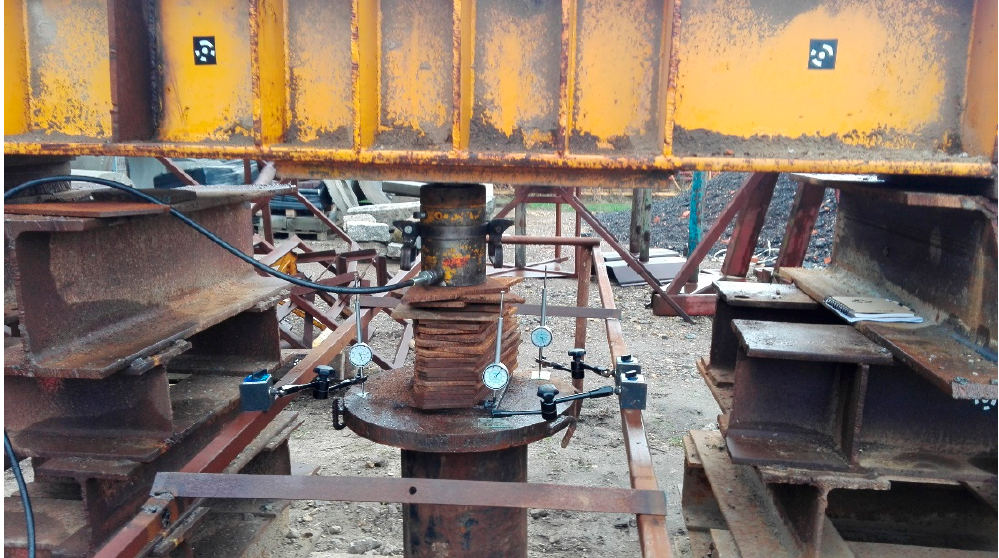
Figure 4. The SLT appliance with steel reference beams.